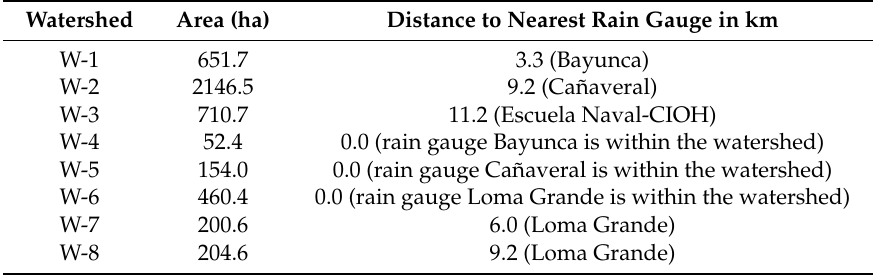
Table 7. Watersheds’ (W) information.